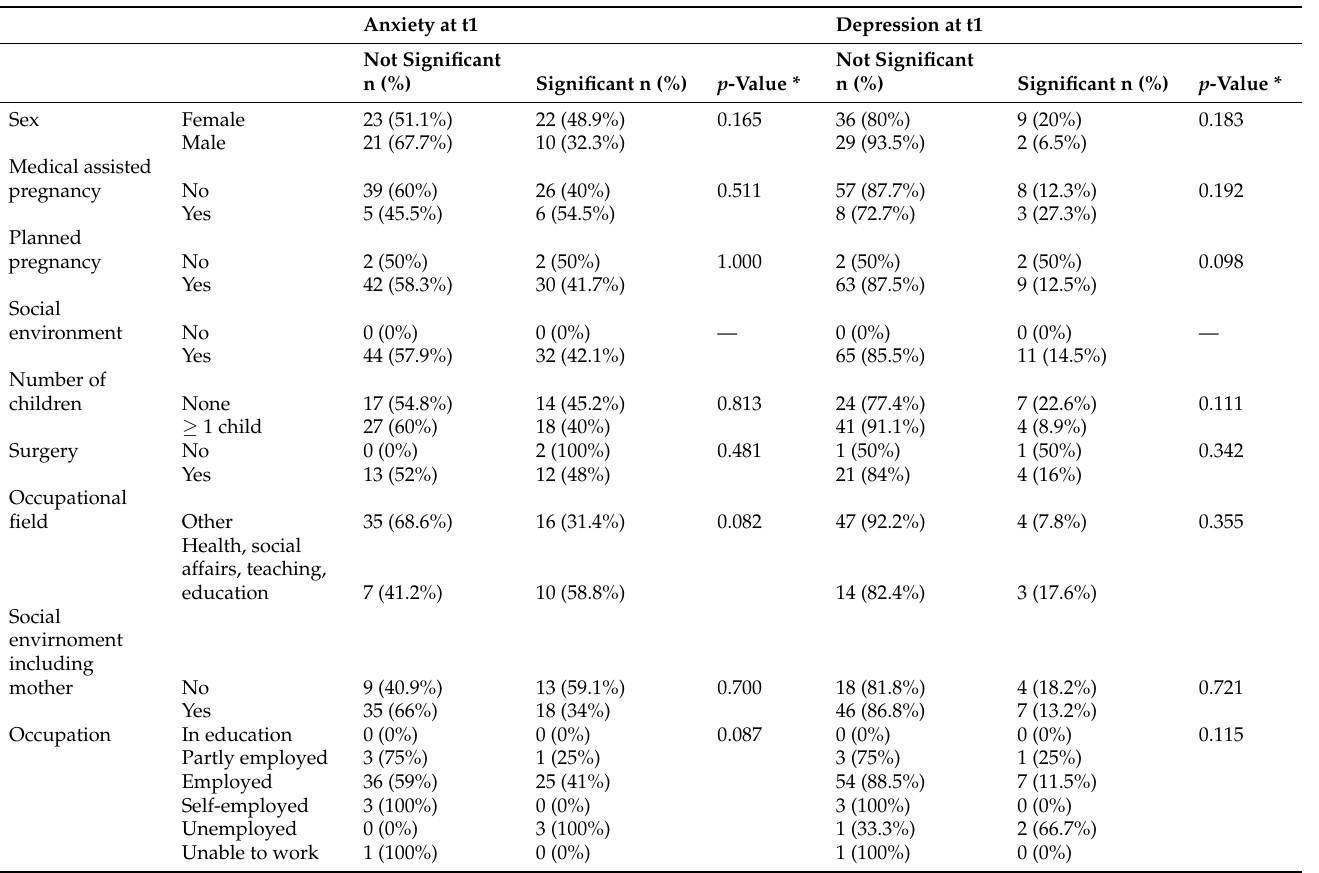
Table 3. Description of the anxious or depressed